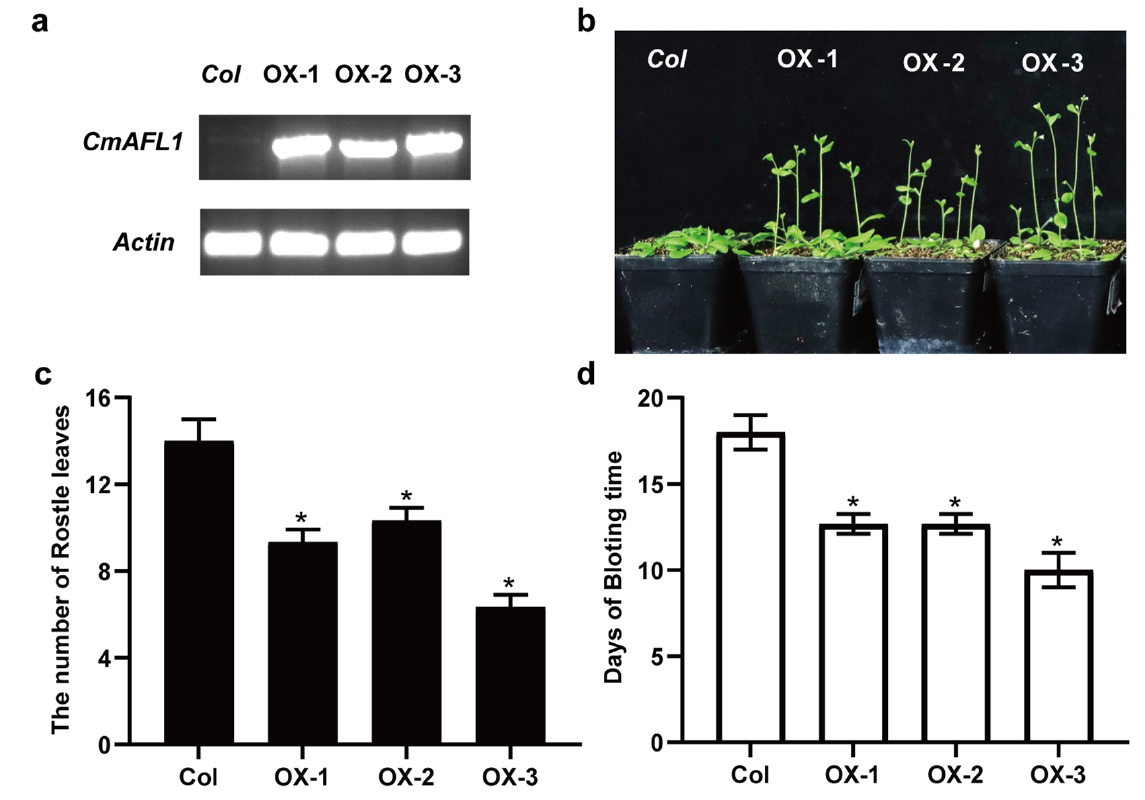
Figure 7. Phenotype following heterologous CmAFL1 overexpression in Arabidopsis thaliana . ( a ) Results of semi-quantitative RT-PCR of CmAFL1 in Col and CmAFL1 -overexpressing plants. ( b ) Phenotype of 35S:: CmAFL1 plants at the bolting stage. Statistics of rosette leaves ( c ) and bolting time (days) ( d ) at the bolting stage. Values are presented as mean of ± standard deviation ( n = 12). Signif- icant di ff erences were determined using Student’s t -test ( * p < 0.05). Col : wild type; OX-1 to OX-3: three independent overexpression lines.